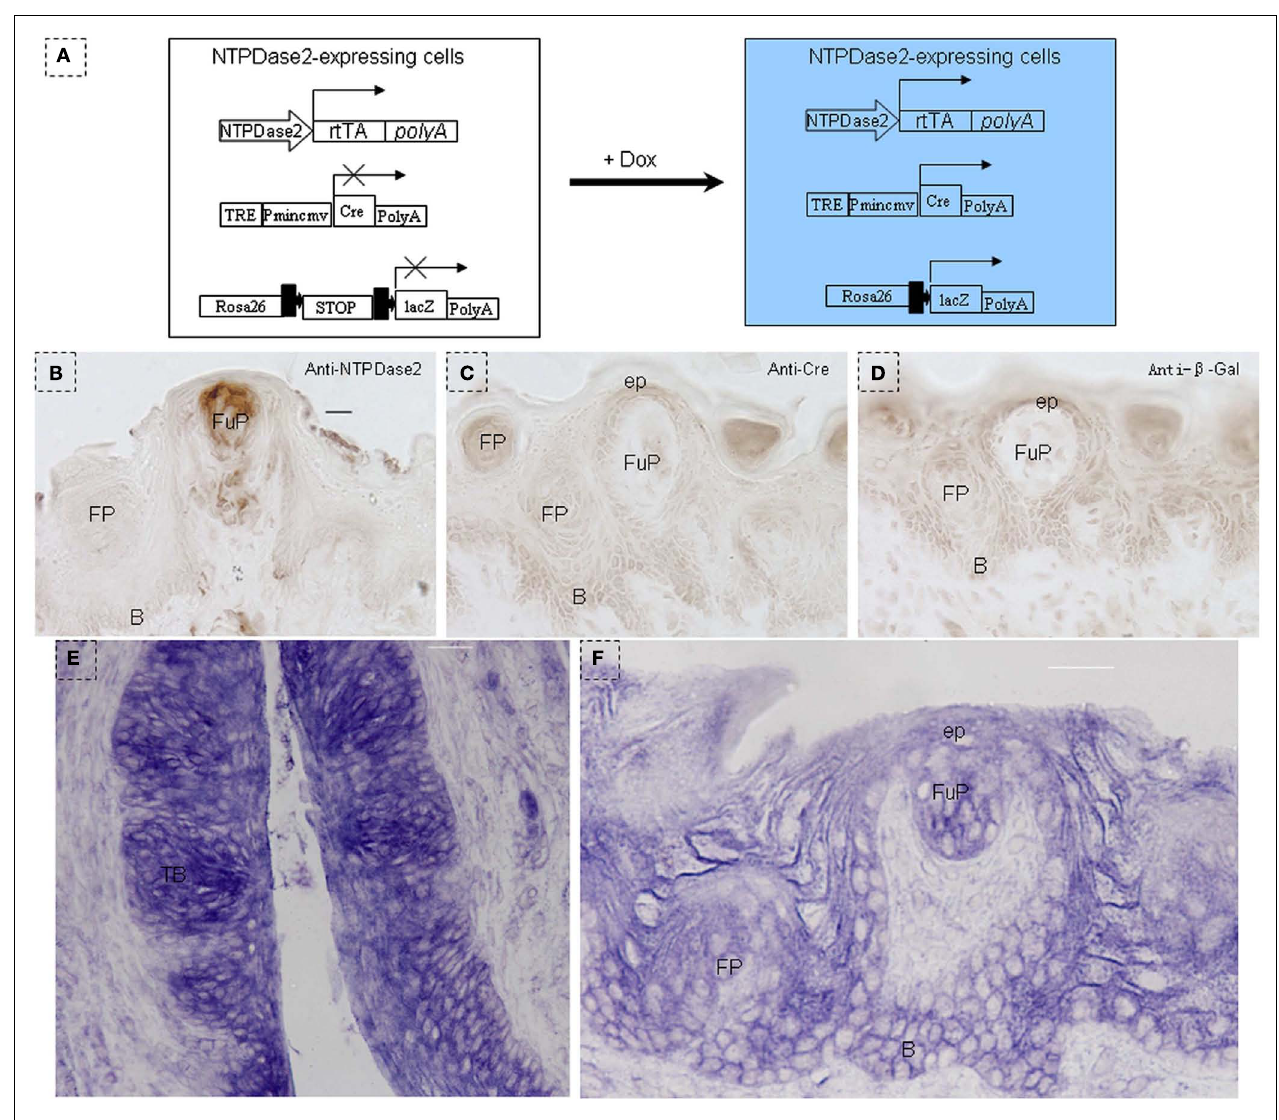
Cre was expressed in lingual epithelia and papillae. (D) Immunohistochemical staining with anti- β -Gal detected LacZ in lingual epithelia and papillae. In situ hybridization with the NTPDase2 probe further revealed the expression of NTPDase2 in lingual epithelia and lingual papillae. (E) CV papillae, (F) fungiform papillae. B, basal cell layer; SB, suprabasal cell layer; CV, circumvallate papillae; FP, filiform papillae; FuP, fungiform papillae; ep, epithelia;TB, taste bud. Scale bar: (B–D) , 12 µ m; (E,F) , 20 µ